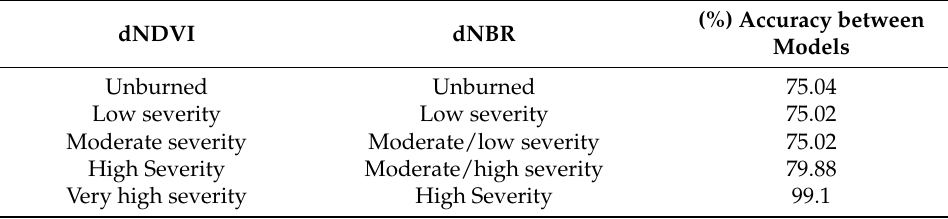
Table 6. Accuracy between fire severity